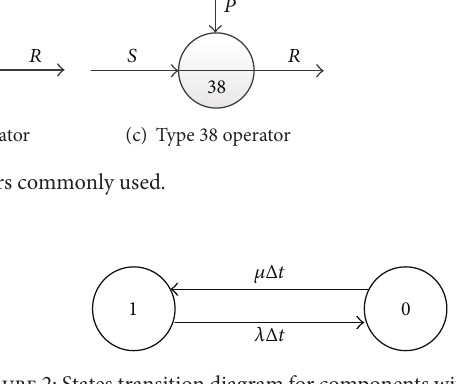
Figure 2: States transition diagram for components with two